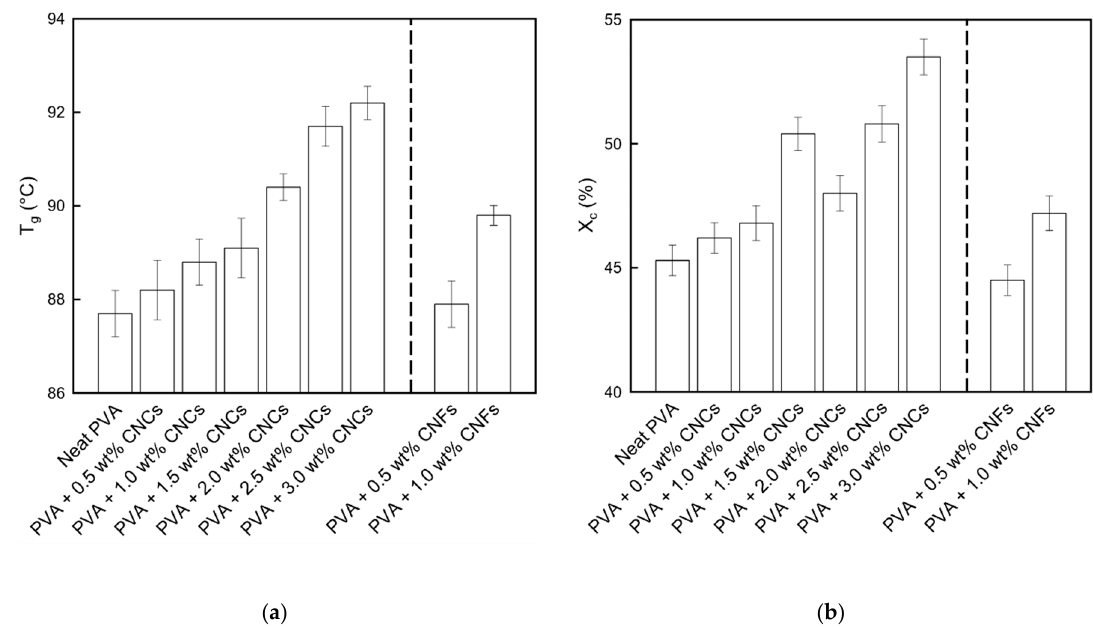
Figure 8. ( a ) T g and ( b ) X c values of the PVA + CNC/CNF nanocomposite films.